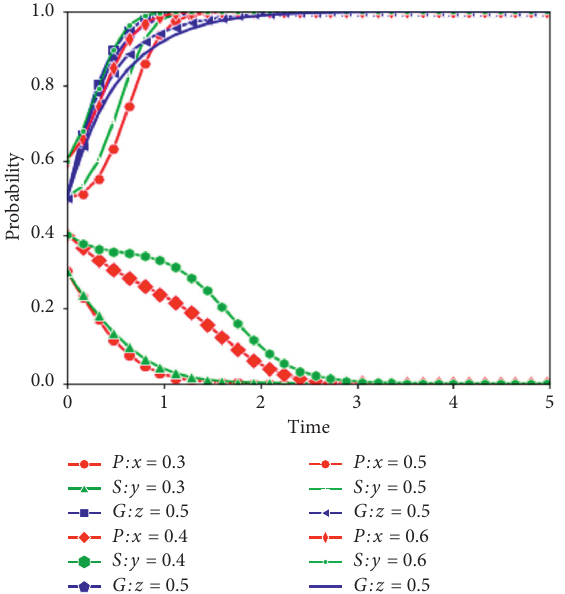
Figure 6: Dynamic evolution process of the tripartite game sub- jects when D